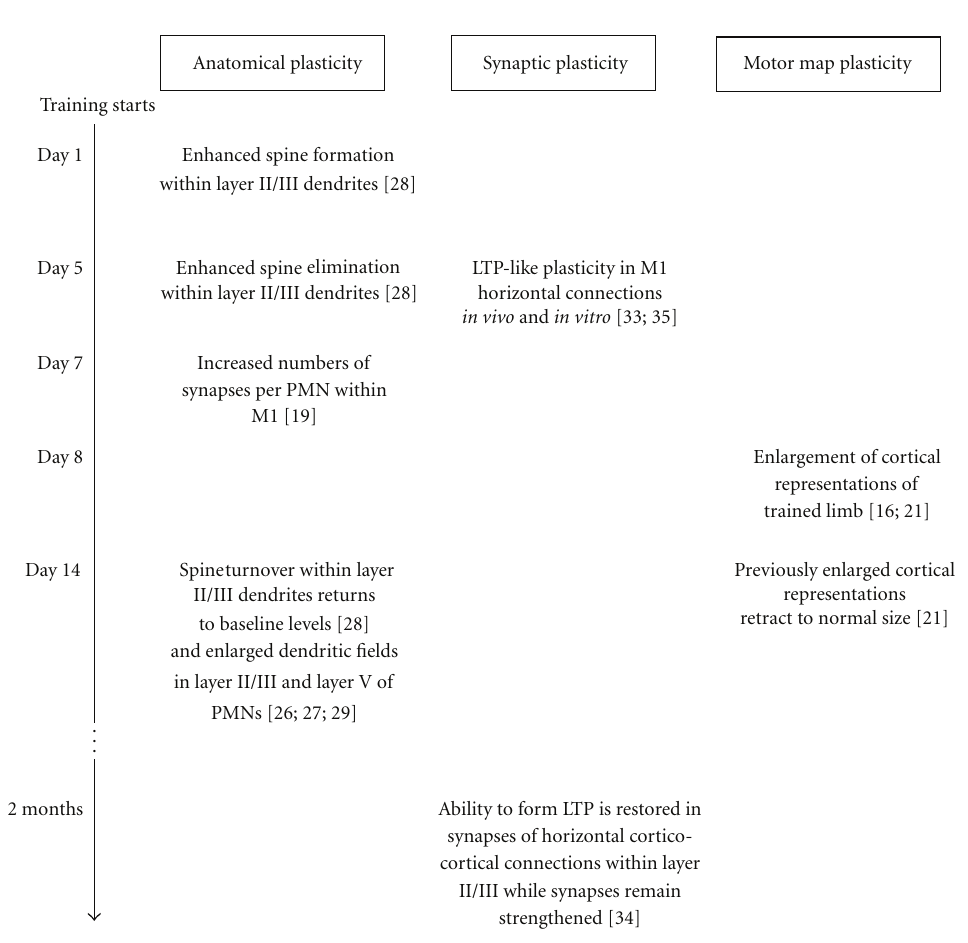
Figure 1: Schematic timescale of plasticity in M1 of rodents at di ff erent levels induced by a skilled reaching task. PMN: pyramidal motor neuron; LTP: long-term